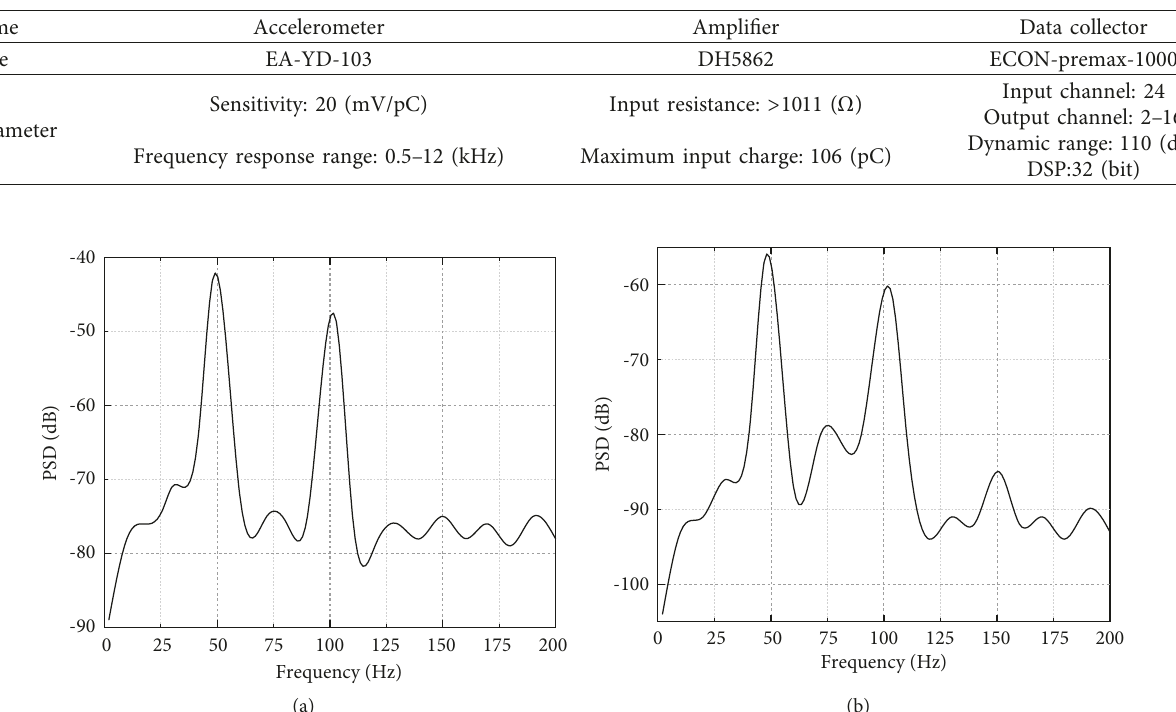
Table 2: Technical parameters of other relevant measurement equipment.